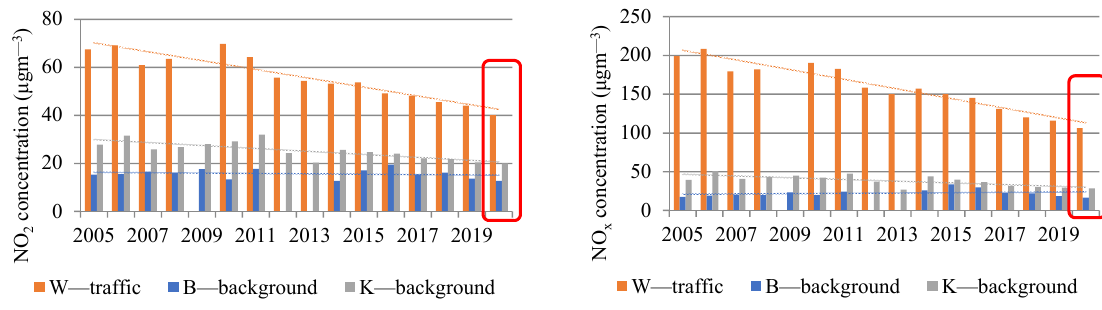
Figure 13. Annual average NO 2 and NO x concentrations with trend lines, 2020 marked by red frame.